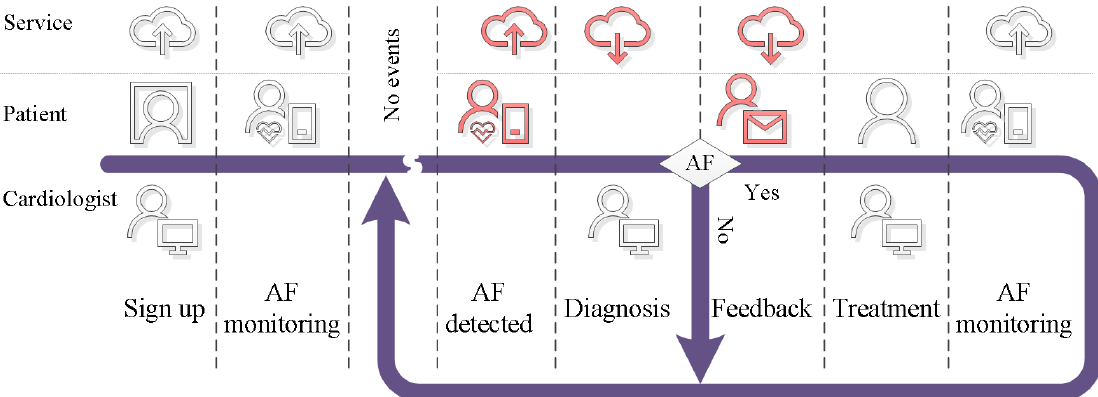
Figure 2. Service